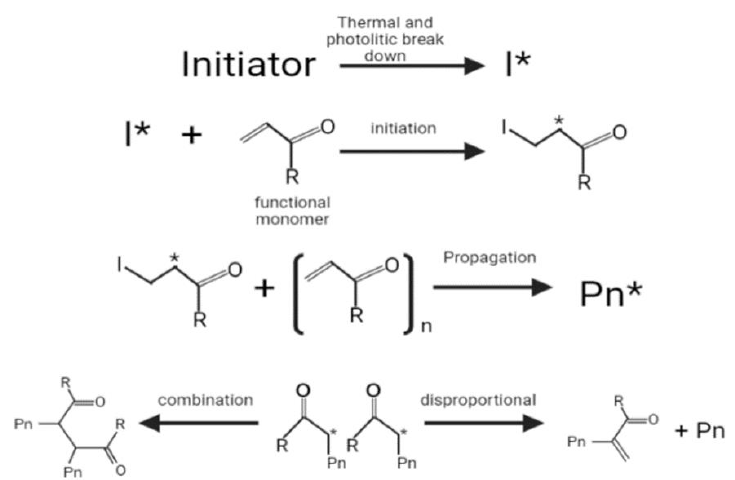
Figure 1. Radical polymerization: 1. Initiation; 2. Propagation; 3. Termination.